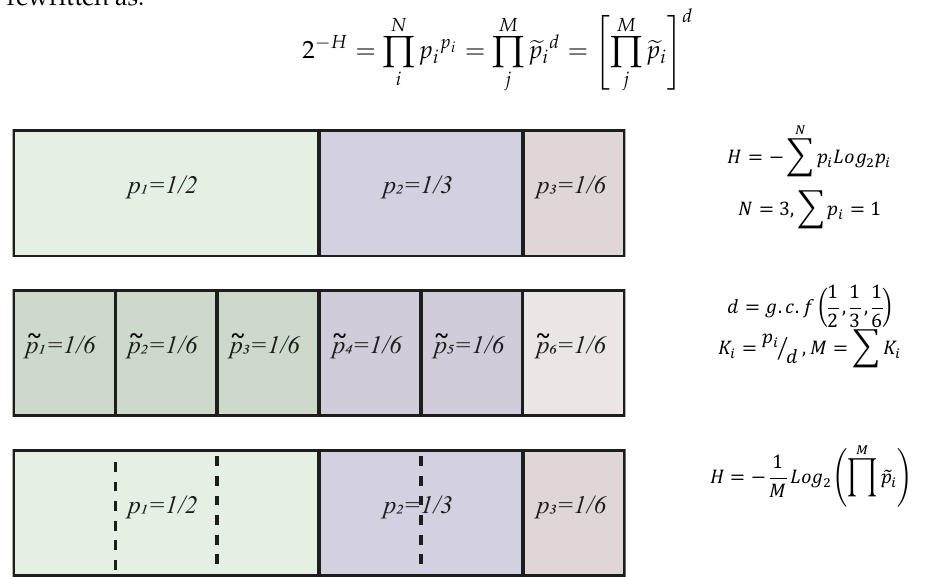
Figure 1. Each discrete set of probabilities 𝑝 𝑖 can be split into a larger set of equally probable events 𝑝̃ 𝑖 .